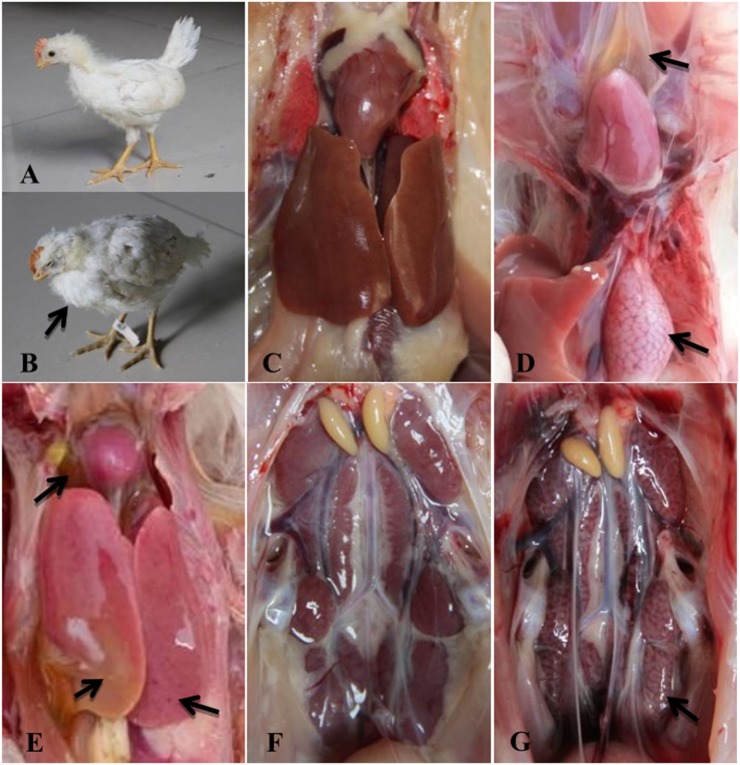
Clinical signs and gross lesions of FAdV-4 SD0828-infected chickens and uninfected controls. (A) Healthy chicken from the control group. (B) Depression and ruffling of neck feathers as seen in an SD0828-infected chicken. (D) Yellow jelly or watery-like exudate in the pericardial sac and glandular stomach swelling. (E) Swollen and pale liver. (G) Nephrotic kidney. (C,F) represent pericardia, livers, and kidneys of chickens from the control group.